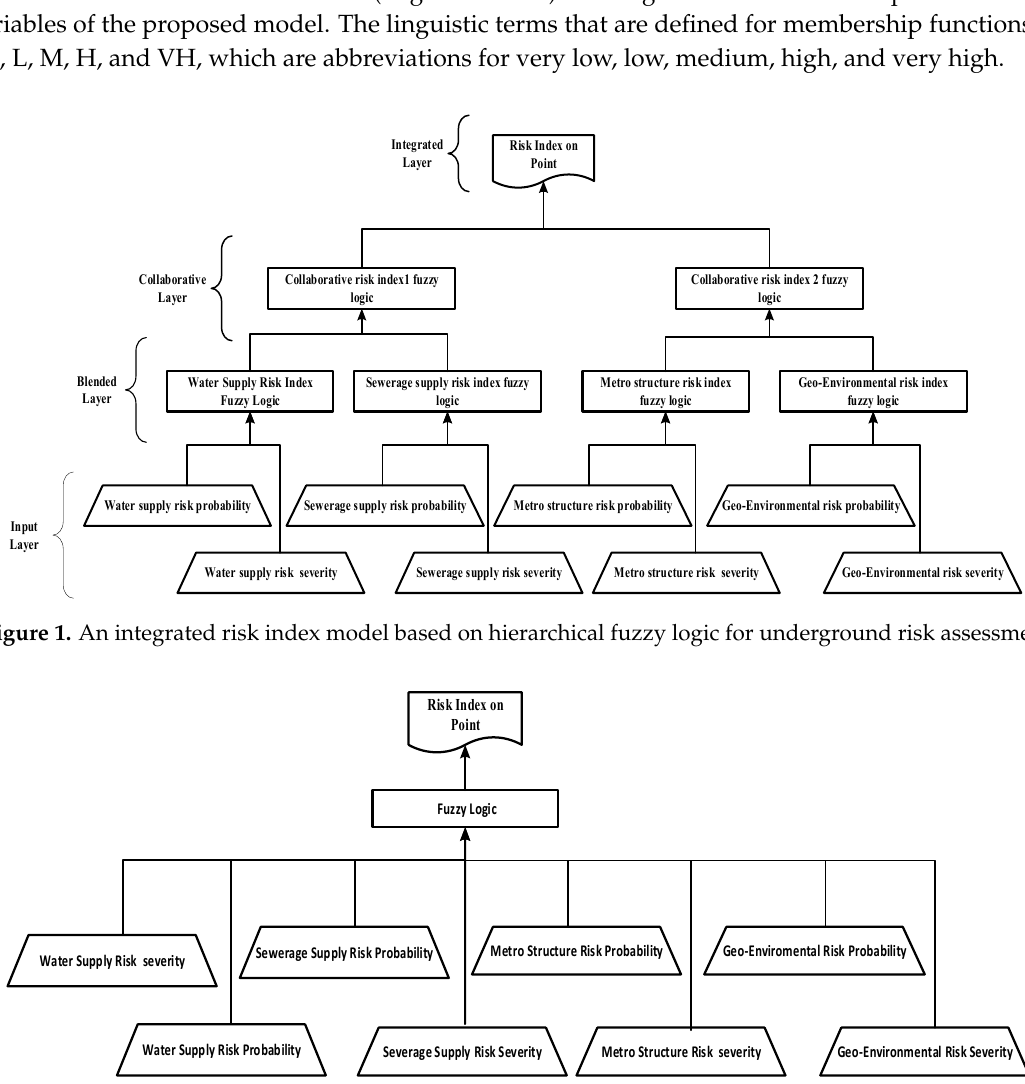
Figure 2. Conventional fuzzy logic with same number of input parameters.